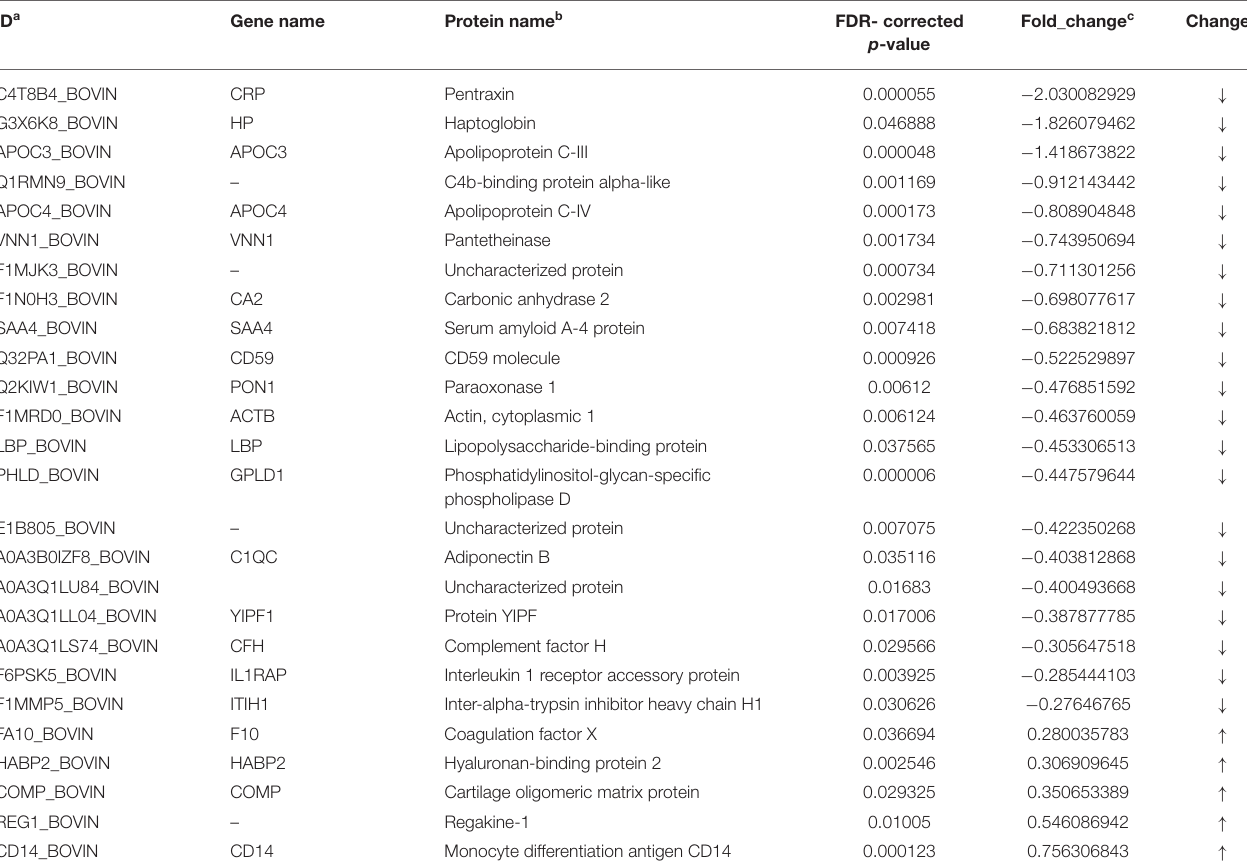
TABLE 1 | Proteins showing significant differences in abundance between plasma from cows with subclinical vitamin E deficiency and healthy control. ID